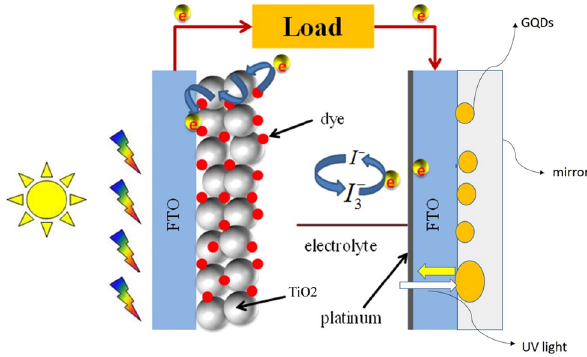
Figure 46: Schematic of the possible mechanism of DSSC enhancement by GQDs. Copied with permission from ref. [ 473 ] ; Elsevier, 2018.